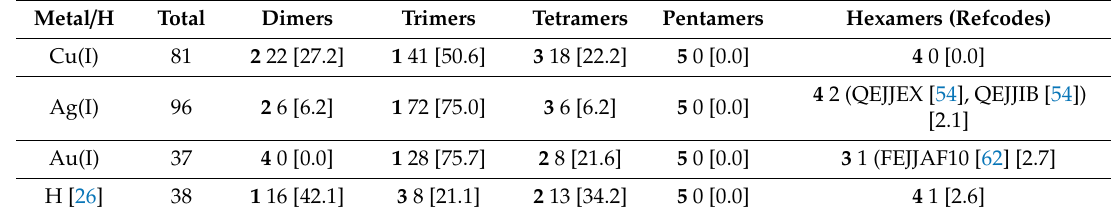
Table 1. Structures found in the Cambridge Structural Database (CSD) for metallacycles formed by pyrazolate ligands and the coinage metals M = Cu(I), Ag(I) and Au(I): (pzM) n for n = 2, 3, 4, 5 and 6. The percentages are in brackets. For comparative purposes, the results for NH-pyrazoles (cyclamers) are also provided. The relative order from frequent to zero (pentamers) is in bold.